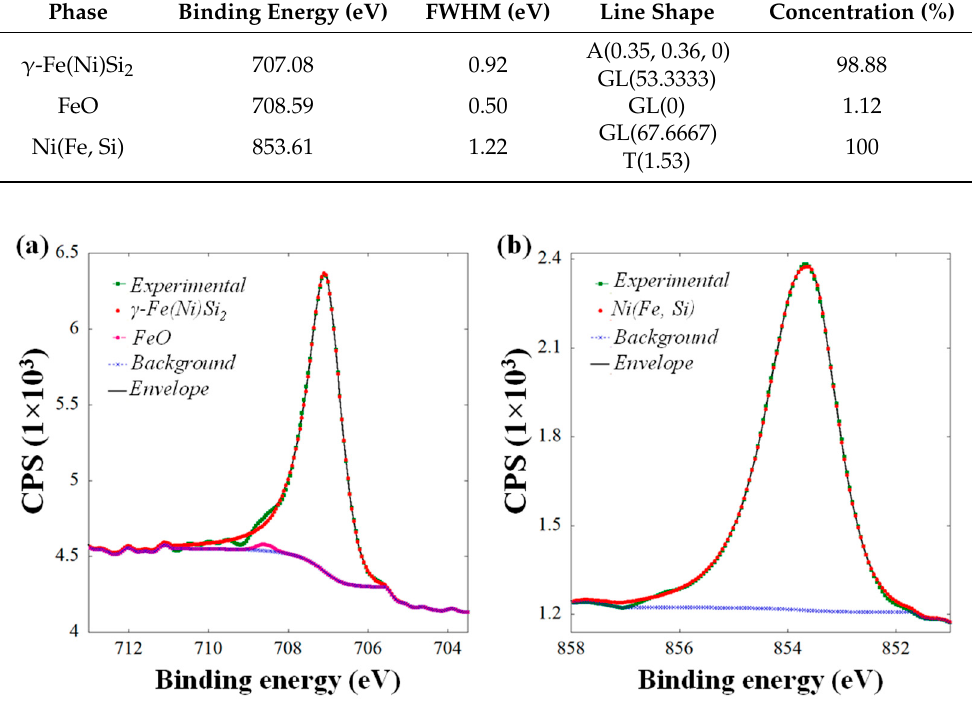
Figure 2. High resolution core level XPS spectra of ( a ) Fe 2 p 3/2 and ( b ) Ni 2 p 3/2 from the self-assembled NSs shown in Figure 1e.